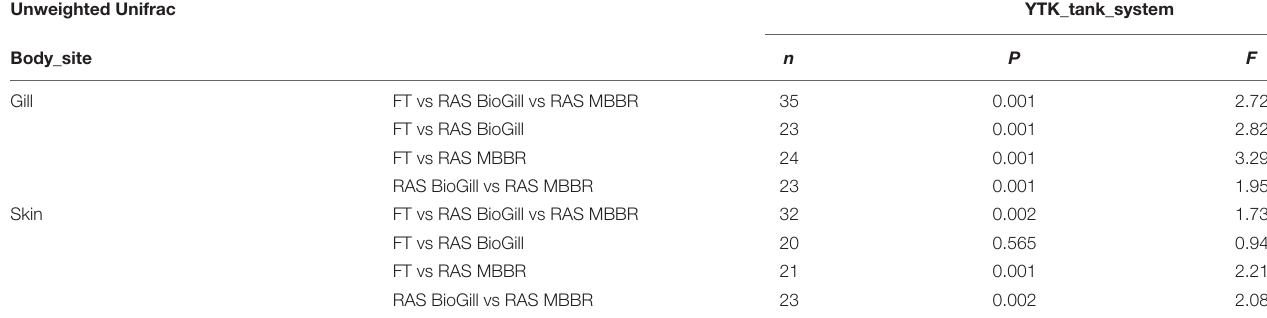
TABLE 1 | Multivariate statistical comparison of impacts of rearing system across gill and skin (PERMANOVA, 999 permutations). Unweighted Unifrac